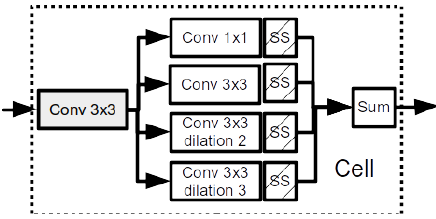
Figure 5. Cell search space on this